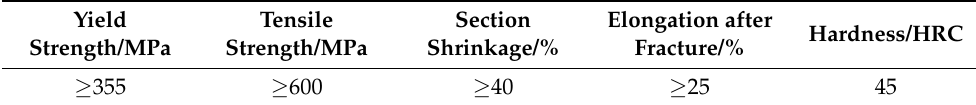
Table 2. Mechanical properties of 45 steel.